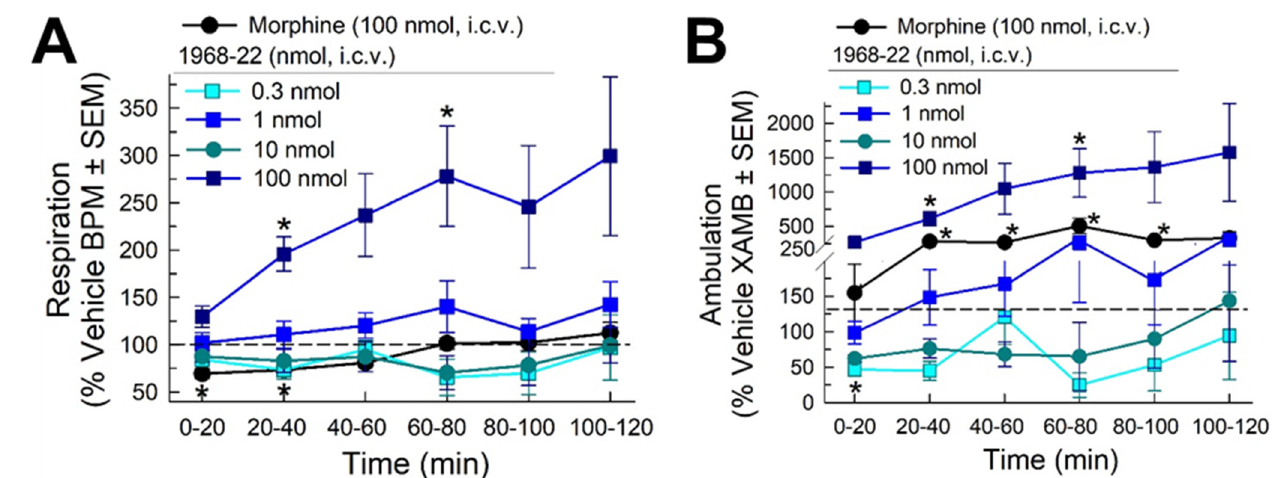
Figure 7. Effects of 1968-22 on ( A ) respiration and ( B ) ambulation in C57BL/6J mice tested in the CLAMS/Oxymax system. Respiration and ambulation were monitored after administration of morphine (100 nmol, i.c.v.), 1968-22 (0.3, 1, 10 or 100 nmol, i.c.v.) or vehicle using the CLAMS/Oxymax system. Data from eight mice presented as % vehicle response ± SEM; breaths per minute, BPM ( A ) or ambulation, XAMB ( B ). * significantly different from vehicle control response ( p < 0.05); two-way RM ANOVA with Dunnett’s multiple comparison post hoc test.